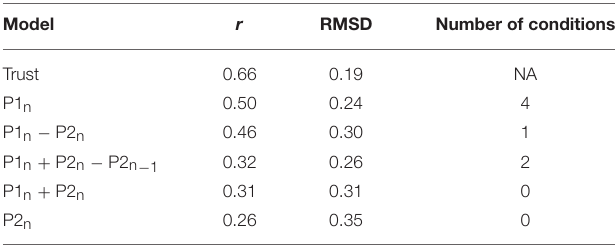
TABLE 6 | Correlation ( r ) and root mean squared deviation (RMSD) between models and human data for the original model (trust) and five model variants run in the same 16 conditions as the human